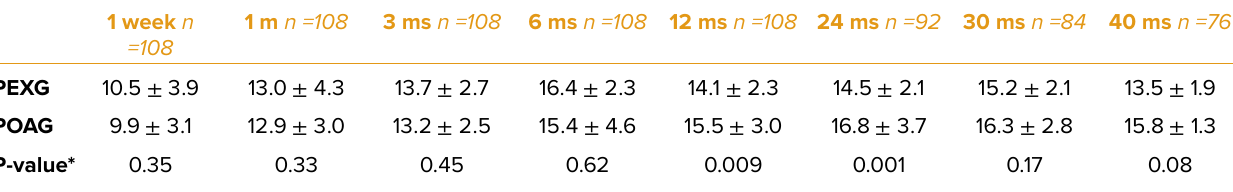
Table 2. Mean IOP (mmHg) over 40 months (ms) follow-up in the two study